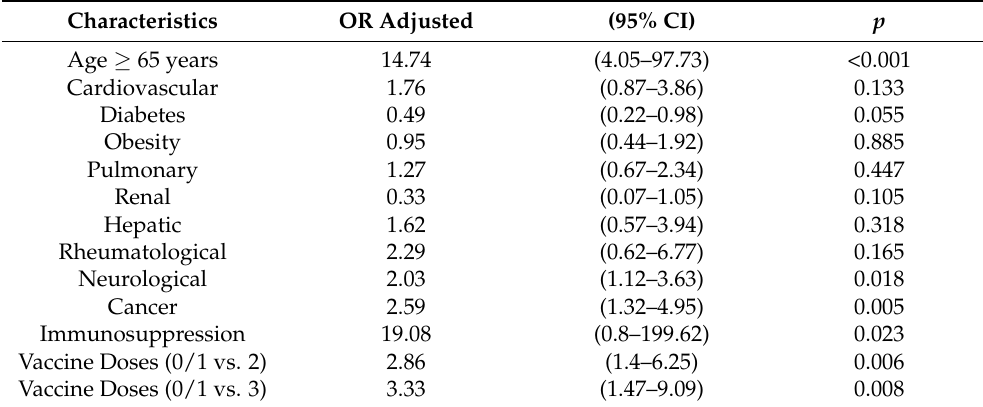
Table 8. Results of the multivariate logistic regression model predicting death in patients hospitalized during the fifth pandemic